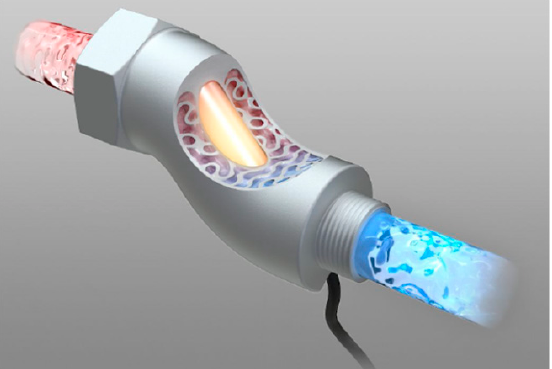
Figure 8. View of the heat exchanger for heating the water supplied to the washing machine [125].